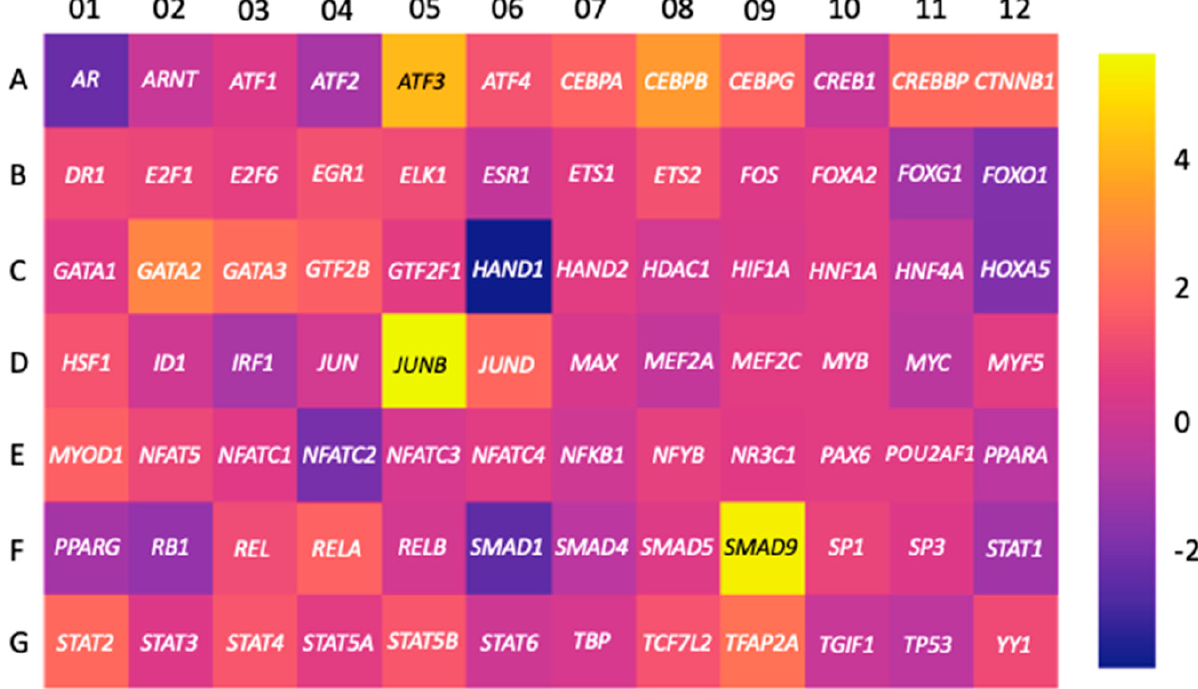
Figure 5. Changes in the expression of genes encoding TFs in JEG-3 cells. Cells were treated 8 − Br − cAMP (250 µM) for 36 h to induce trophoblastic differentiation and Qiagen RT 2 Profiler™ PCR Array kit was used to assess fold changes in gene expression between differentiated and control cells presented as a heatmap.